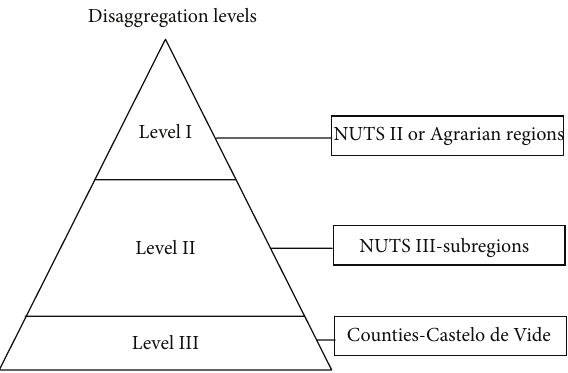
Figure 2: The territorial disaggregation